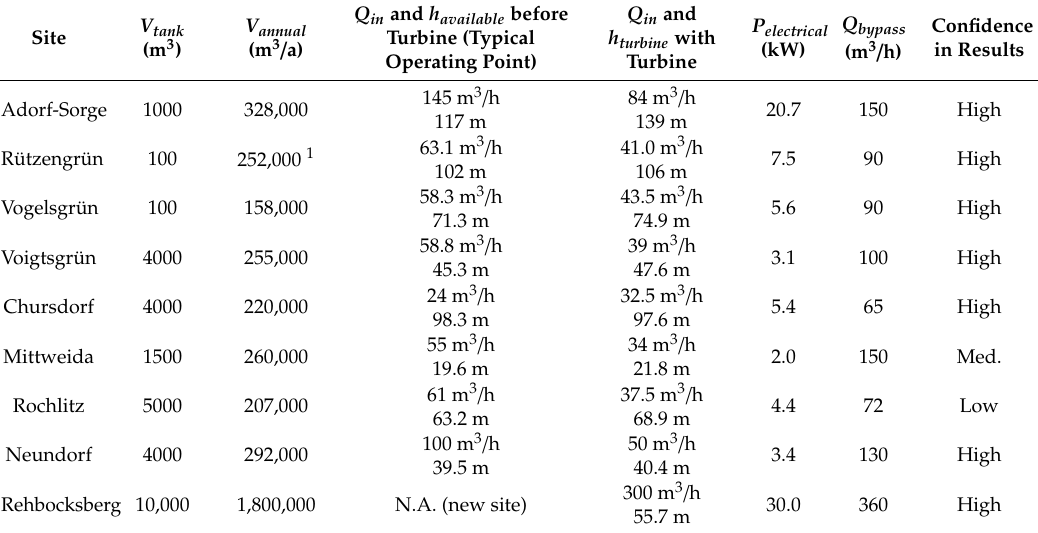
Table 5. Summary of the site characteristics, with selected design results obtained using the 2018 HTWD